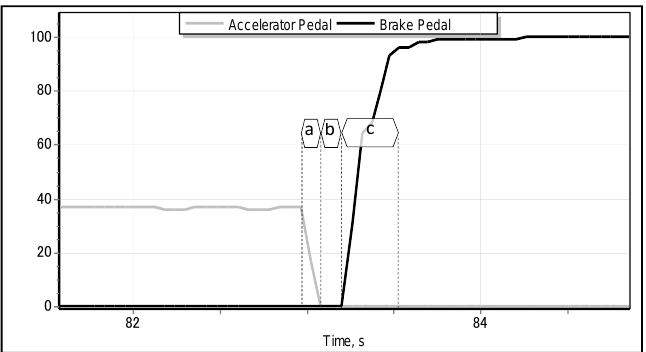
Figure 2. Experimental environment: full-scale Forum-8 drive simulator.